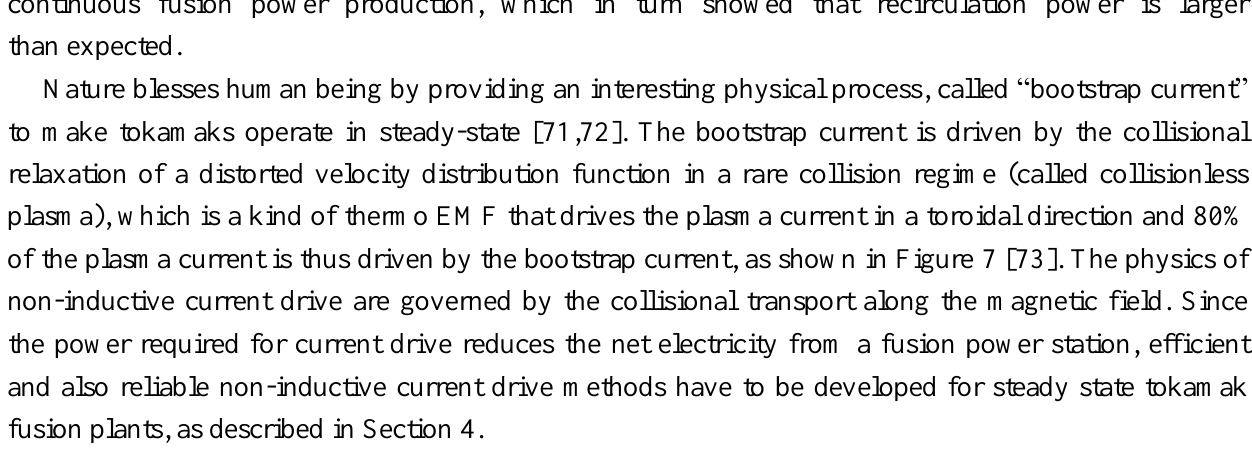
Figure 7. Comparison of the experimental and theoretical bootstrap current fractions in JT-60 [73].